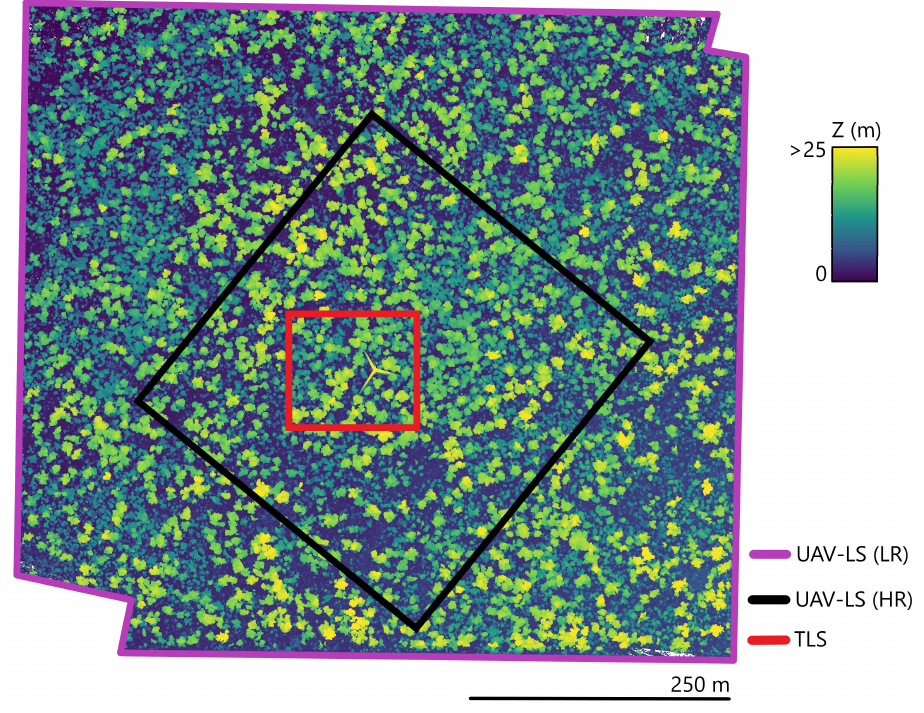
Figure 1. UAV-LS (low resolution) point cloud, indicating the boundaries of all data types. The colour code represents the height above terrain. The maximum tree height is approximatively 25 m, and the open canopy allows a substantial